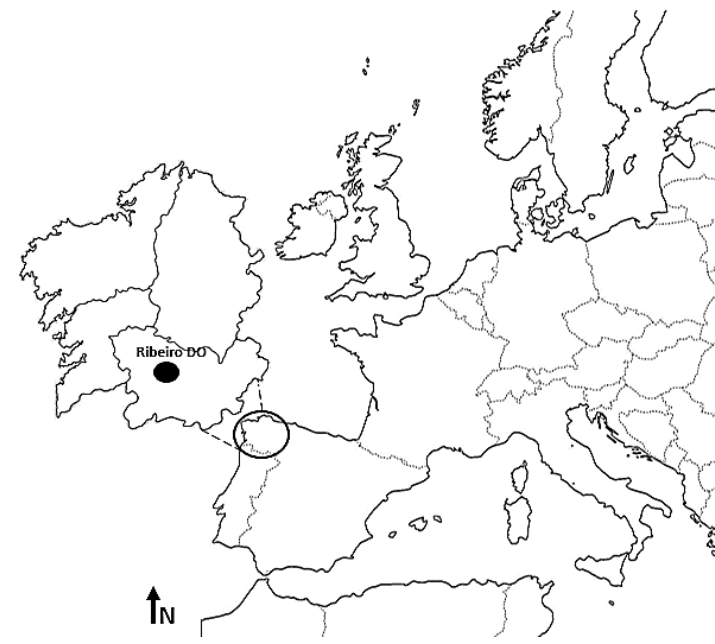
Figure 5. Location of the study area.